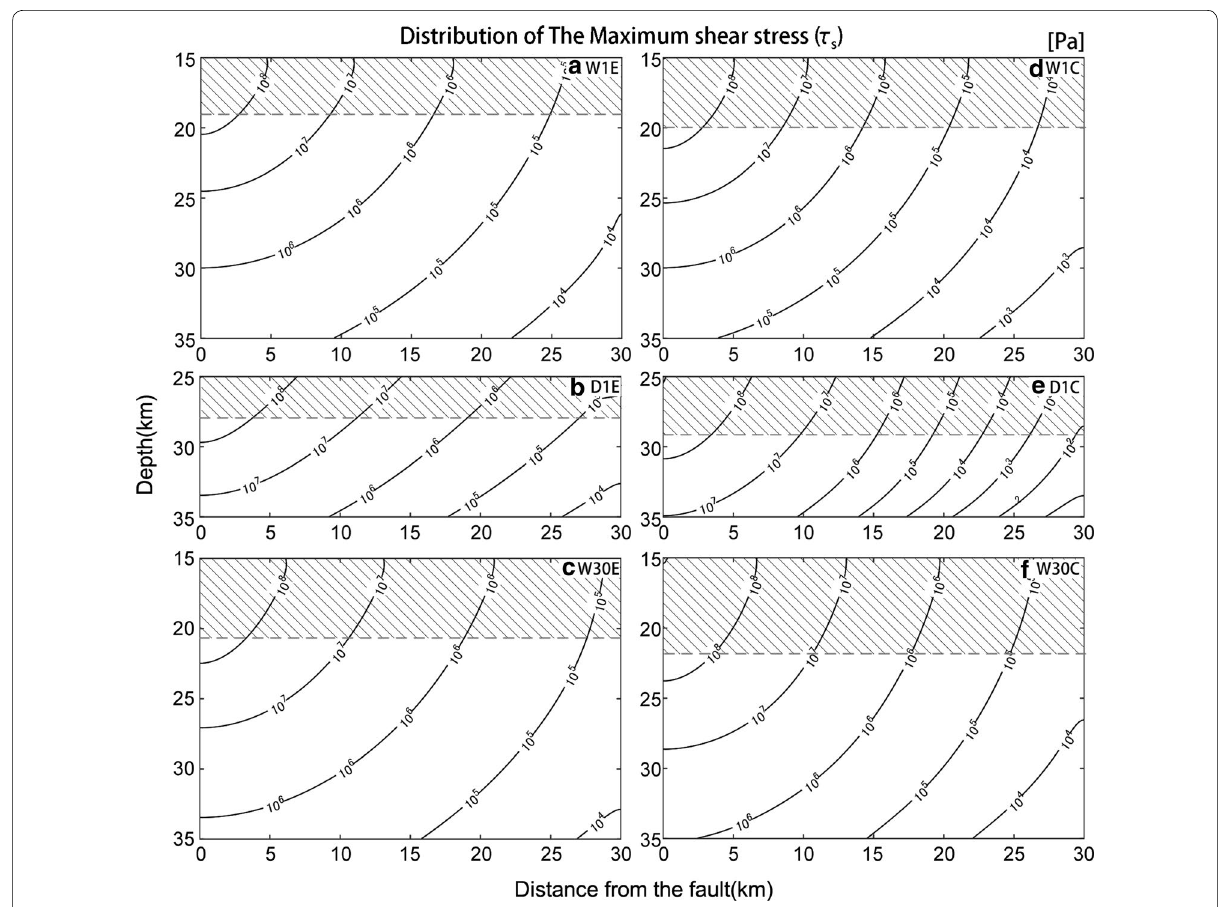
Fig. 4 Contours of shear stress ( τ s ) in the lower crust as a function of depth and distance from the fault for models a W1E, b D1E, c W30E, d W1C, e D1C, and f W30C. The thickness of the lower crust and the depth of the BDT are dependent on the assumed rheology and far-field velocity ( v 0 ). The gray broken lines represent the BDT